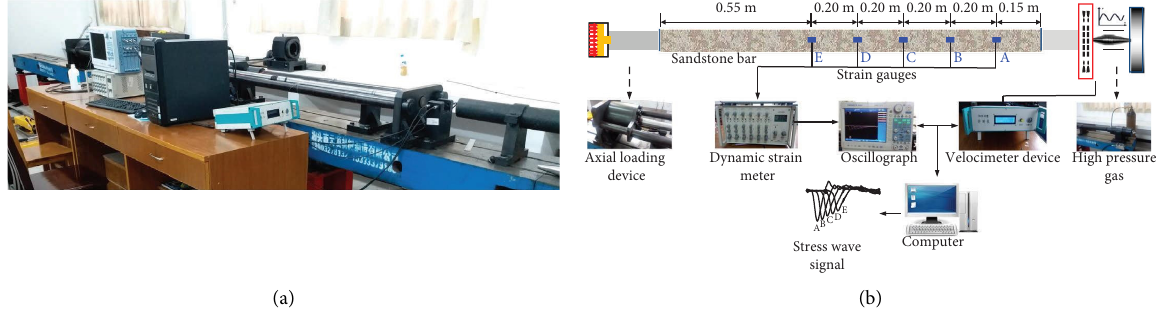
Figure 1: Diagram of experimental system.